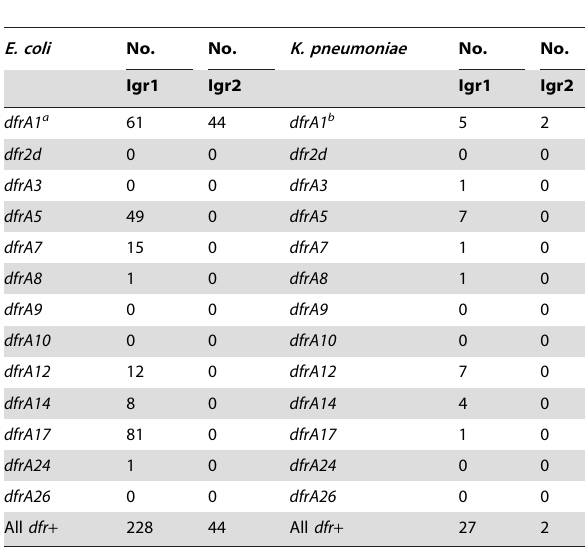
Table 6. No. of K. pneumoniae (n=54) isolates resistant to trimethoprim only and in combination with other antibiotics and in relation to the presence of